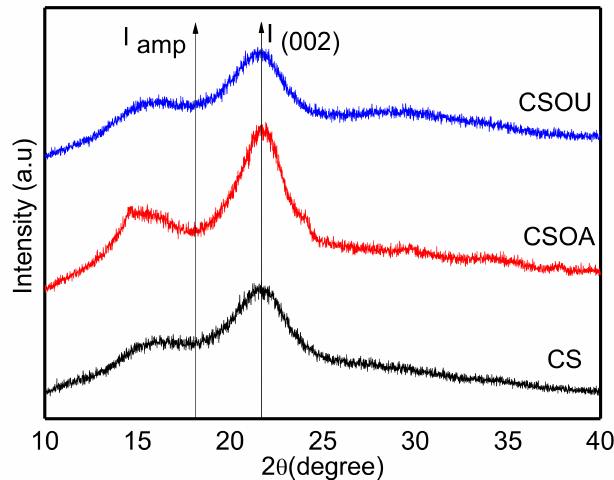
Figure 3. XRD patterns of the CS before and after various